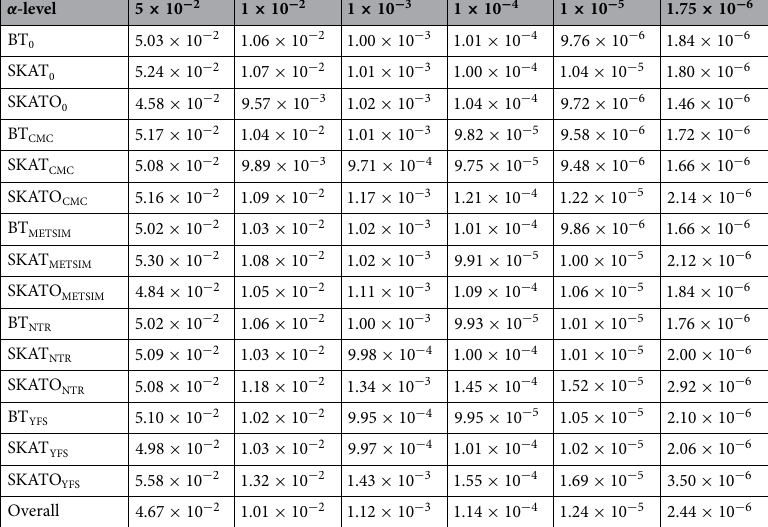
for gene AGTRAP at 5 × 10 − 2 , 1 × 10 − 2 , 1 × 10 − 3 , 1 × 10 − 4 , 1 × 10 − 5 , and 1.75 × 10 − 6 significance levels. With 10 7 replications, a Bonferroni corrected significance level of 1.75 × 10 − 6 can be reached to obtain the empirical type I error rates (i.e., for 28,625 genes in the real data analysis section, the Bonferroni corrected significance level is 0.05 / 28625 = 1.75 × 10 − 6 at 5% significance level). We further evaluate type I rates based on the other 17 genes. To save computational time, we use 2 × 10 5 replications to evaluate type I error rates of Overall for the 17 genes at significance levels of 1 × 10 − 2 , 1 × 10 − 3 , and 1 × 10 − 4 . Table 2 and Supplementary Table S2 show the estimated type I error rates of Overall under various nominal significance levels for gene AGTRAP and the other 17 genes, respectively. From these tables, we can see that our proposed method can control type I error rates very well at different significant levels.